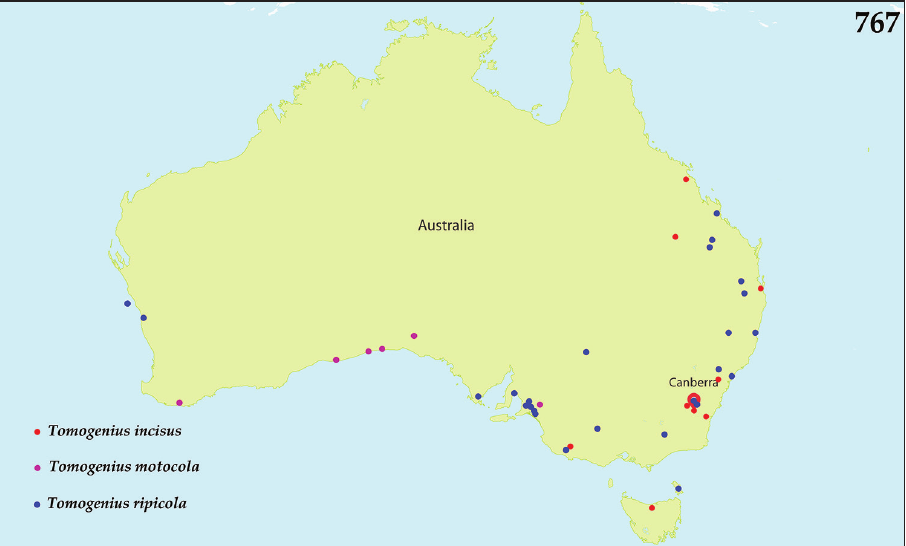
Figure 767. Distribution of the genus Tomogenius Marseul, 1862 in Australia: Tomogenius incisus (Erichson, 1842); Tomogenius motocola Mazur, 1990 and Tomogenius ripicola (Marseul, 1870).